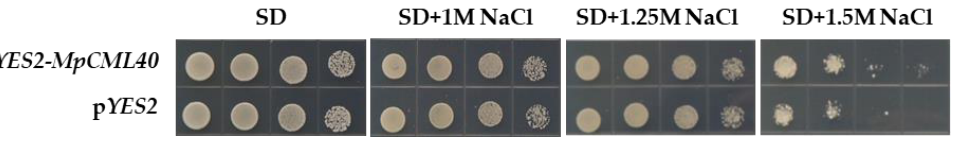
Figure 5. Salt tolerance of the pYES2-MpCML40 transformed yeast. Series dilutions (1, 10, 100, 1000 folds) of the pYES2- MpCML40 transformed yeast and pYES2 (empty control) transformed yeast were grown on SD/-Ura agar plate containing different concentrations of NaCl (1 M, 1.25 M, 1.5 M).